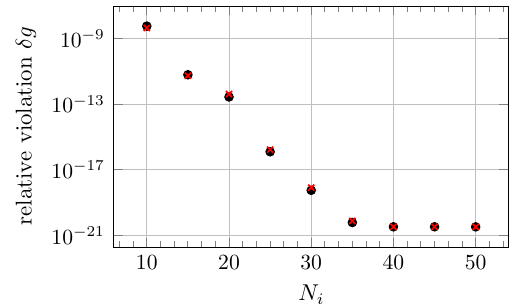
Fig. 6 The relative Gauss constraint violation for the semi-implicit scheme as a function of the number of iterations N i of the damped fixed point iteration. For this plot we used a simulation box of volume V = ( 1 . 5fm ) × ( 6fm ) 2 on a lattice with N T = 256 points in the trans- verse directions and N L = 128 points in the longitudinal direction. Otherwise, we use the same initial conditions as in Figs. 4 and 5. At the beginning of the simulation at t = 0fm / c the constraint is conserved up to machine precision by construction. We then let the nucleus propagate until t = 0 . 5fm / c and compute the violation of the Gauss constraint (black dots). We also compare to the constraint violation after only a single evolution step (red crosses), which does not differ much from the violation after a larger number of time steps. It is evident that the vio- lation systematically converges towards zero (up to machine precision) as we increase the number of iterations N